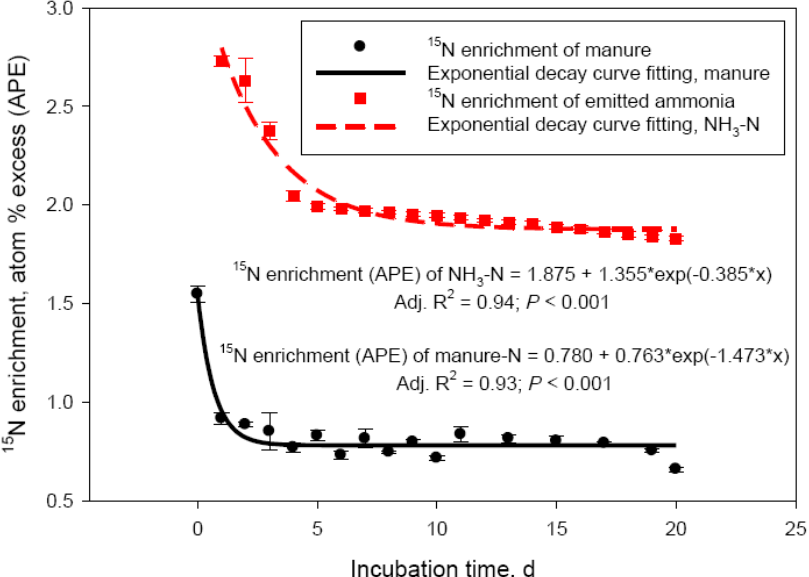
Figure 3. 15 N-enrichment (atom % excess; APE) of ammonia- and manure-N in Exp. 3 (means ± SE; n =